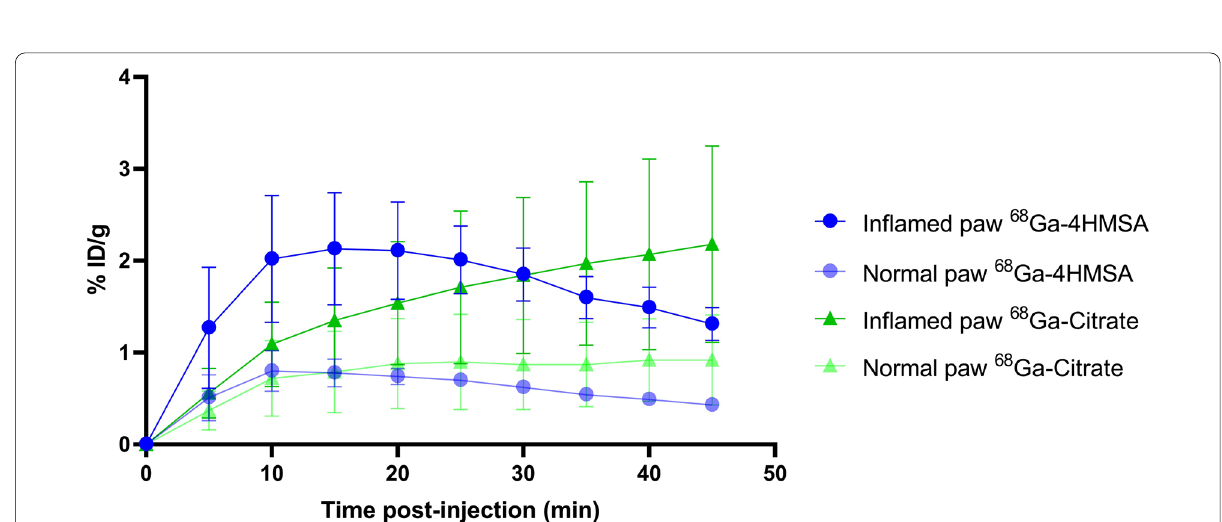
Fig. 8 Paws uptake of [ 68 Ga]Ga‑4HMSA and [ 68 Ga]Ga‑citrate at Day 1